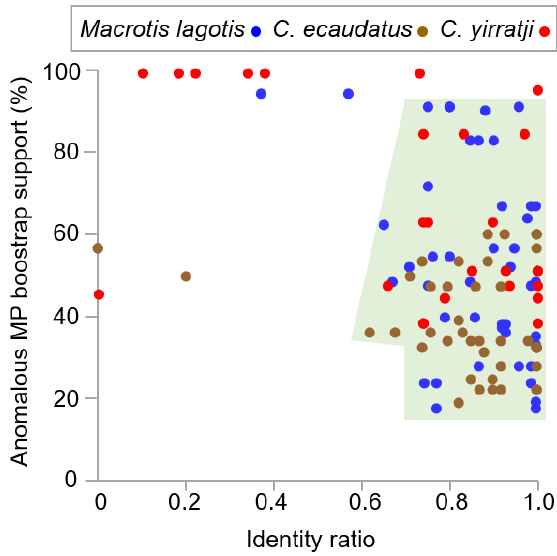
Figure 2. Scatterplot of the identity ratio from 150 bp BLAST windows versus highest anomalous MP bootstrap support among 300 bp MP windows that fully include that BLAST window, for Macrotis lagotis (blue), C. ecaudatus (brown) and C. yirratji (red). All BLAST windows are included from 12S/16S rRNA and Cytb . In the MP bootstrap analyses, the Cytb 3rd codon positions were RY coded. The shaded area covers 95% of Macrotis and 95% of C. ecaudatus windows. Identity ratio is a metric for the specificity of the identity to the top hit (I A ) relative to the identity for the next most similar peramelemorphian genus (I B ). Identity ratio = (1 − I A )/(1 − I B ). Anomalous MP bootstrap support is whichever is the higher discrepancy with prior expectations, the support for the focal taxon either being excluded from other peramelemorphians and Notoryctes or being a shallow-level sister group with or within another genus. Scores on these metrics for each window are provided in Tables S3 and